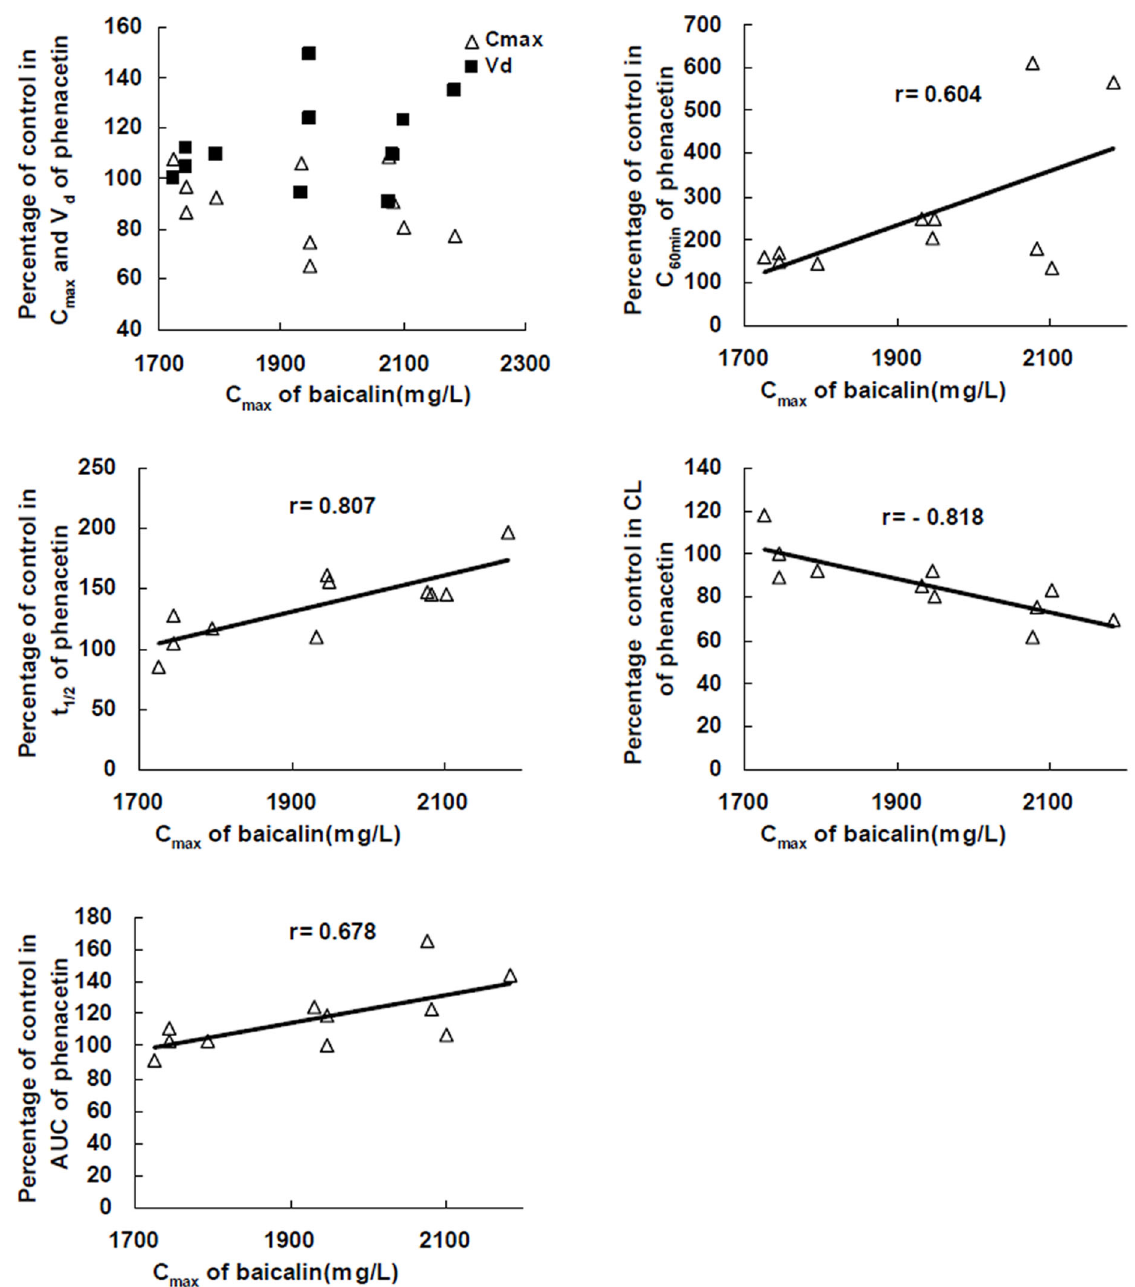
Figure 4. Plots of percentage of control in pharmacokinetic parameters of phenacetin versus C max of baicalin.